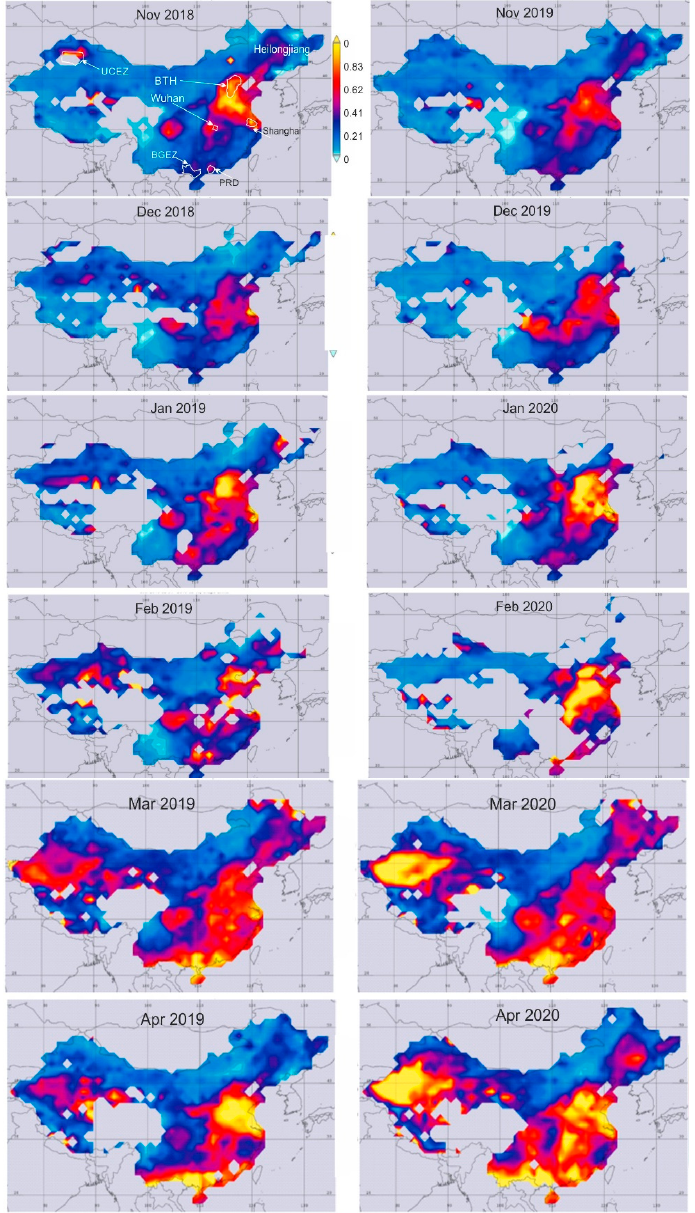
Figure 1. Aqua moderate resolution imaging spectrometer (Aqua MODIS) DTB monthly aerosol optical depth (AOD) at 550 nm from November 2018 to April 2019 (Column 1), and November 2019 to April 2020 (Column 2). Monthly averages are generated from the average value of all available pixels over the month. Blank areas represent no data satisfying the quality control threshold. Locations of Beijing–Tianjin–Hebei (BTH), Wuhan, Beibu Gulf Economic Zone (BGEZ), Urumqi–Chiangji Economic Zone(UCEZ),Shanghai,